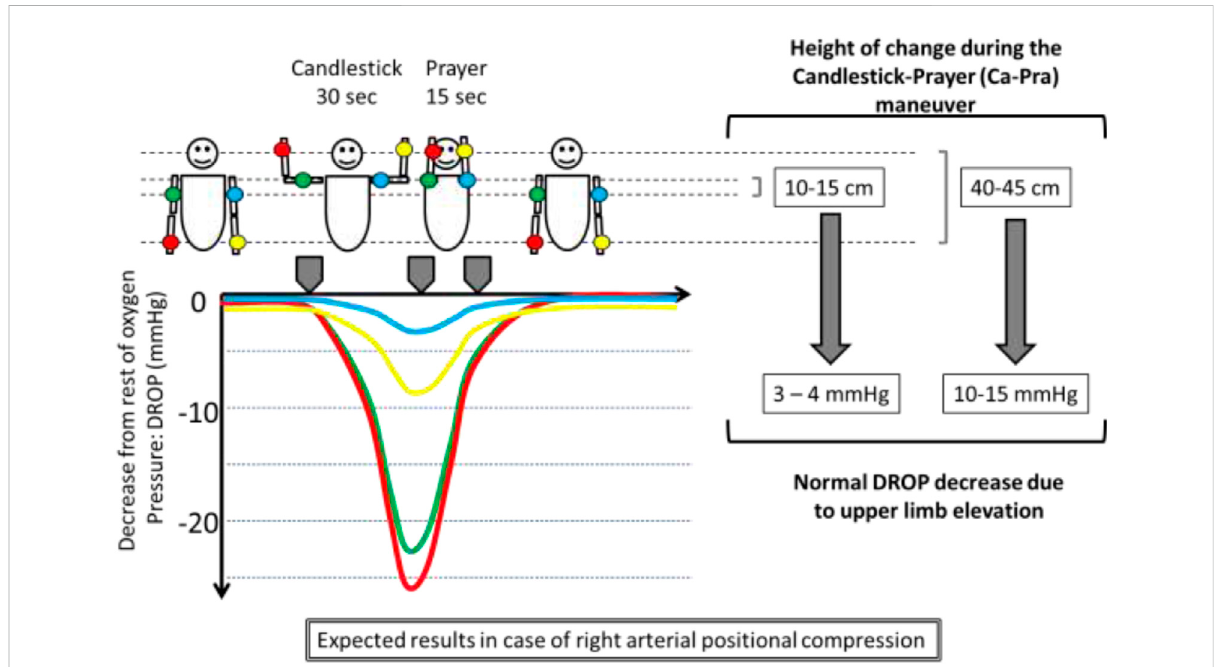
FIGURE 1 Illustration of a unilateral right arterial compression and of the effect of changes in the position of the probes relative to heart level (on the left side of the subject) on TcpO2 values expressed as decrease from rest of oxygen pressure (DROP: limb changes from rest minus chest changes from rest). DROPm is the minimal value observed on the DROP